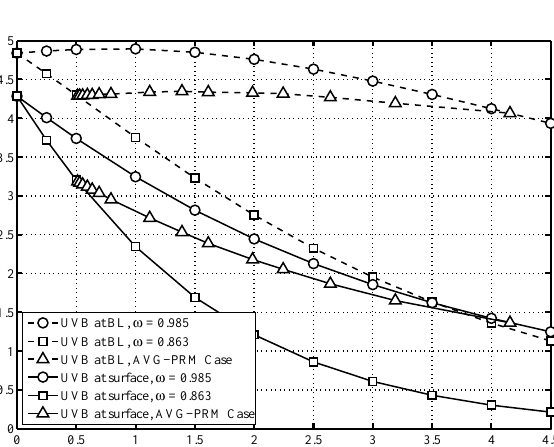
Figure 6. The dependence of UVB irradiance with τ at the sur- face (solid lines) and at the top of the boundary layer (dashed lines) in three cases: ω =0.985 (circle), ω =0.863 (square) and RH- dependent ω (AVG-PRM case; triangle).